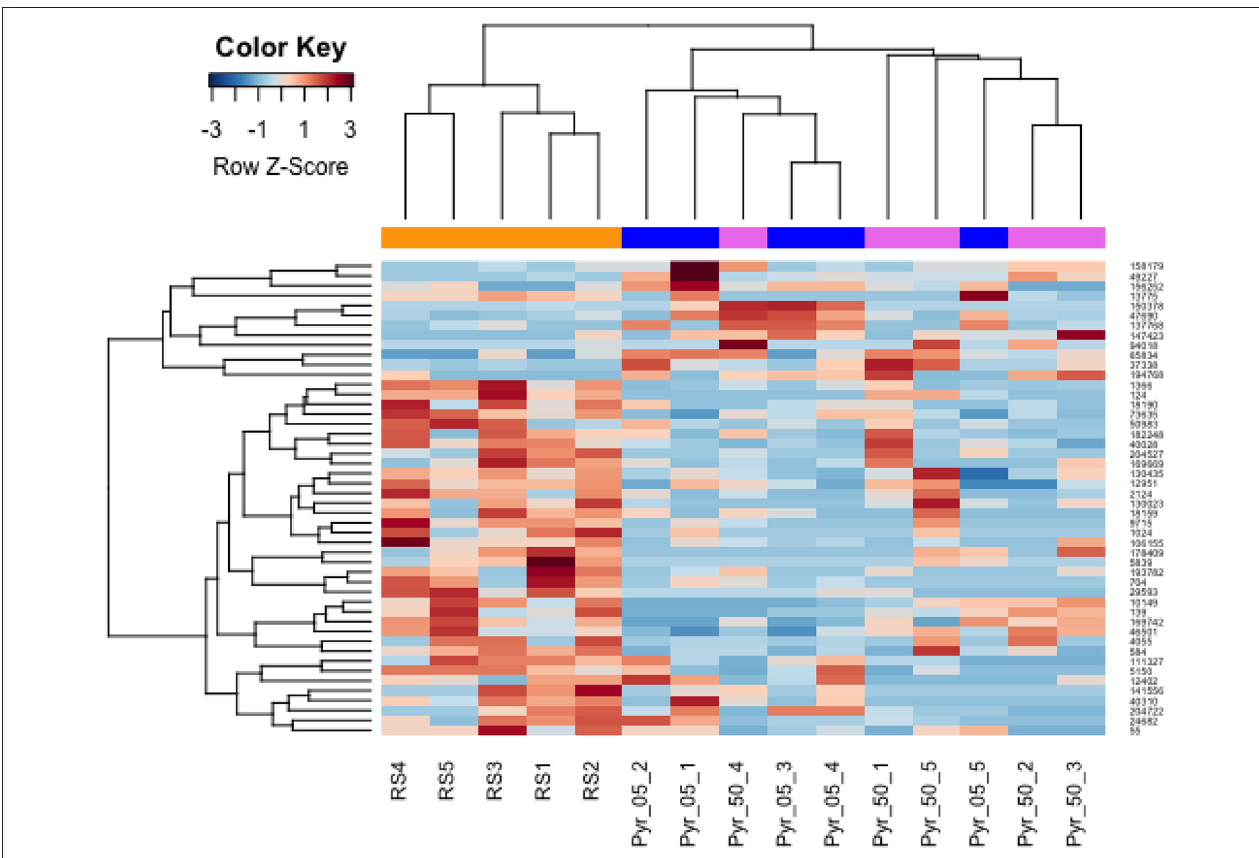
FIGURE 4 | Hierarchical clustering of the 48 proteins modulated in response to pyriproxyfen stress . Orange: controls with solvent; blue: samples treated with 0.5 µ g/L pyriproxyfen; pink: samples treated with 50 µ g/L pyriproxyfen.